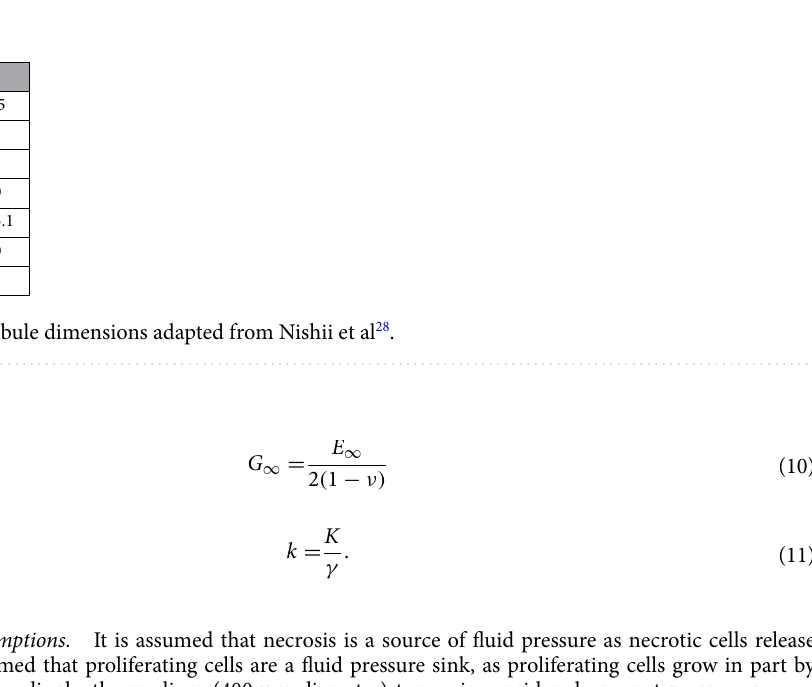
Figure 11. The PVE computational model. Model geometry ( A ) and simulated tumor sizes and positions ( B ). ( A ) Quarter liver lobule showing locations of the pre-terminal portal vein (pre-tPV), terminal portal vein (tPV), and central vein (CV). Dimensions ℓ , w , h , and d are given in Table 2. ( B ) Tumors of different sizes (seed, small, medium) were simulated for different lobule locations, including the midpoint of the central-portal axis (termed the “center” position) and in the portal triad (termed the “portal” position).